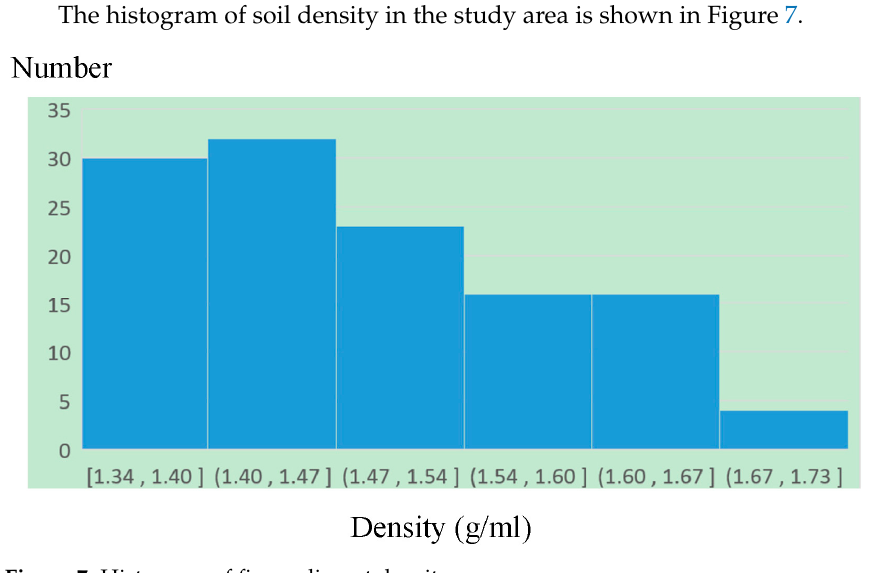
Figure 7. Histogram of fine sediment density.